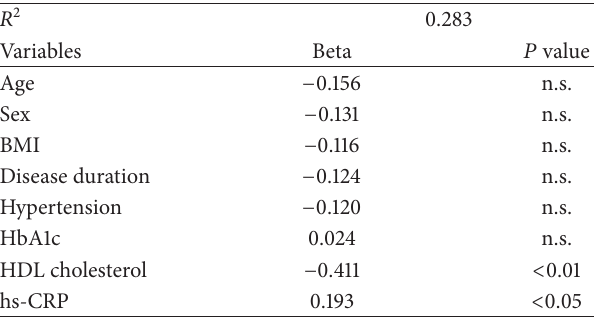
Table 3: Multiple linear regression analysis of plasma LL-37